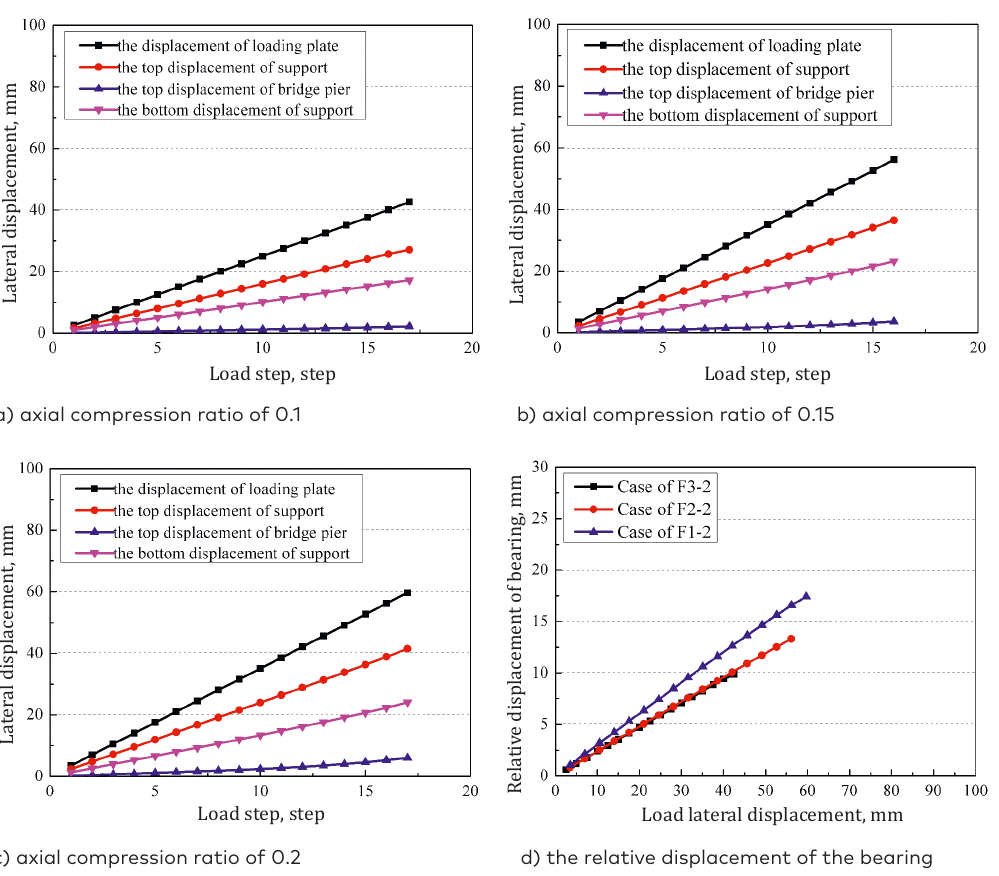
Figure 3. Lateral displacement of the series system with friction coefficient of 0.1 at both ends of the bearing